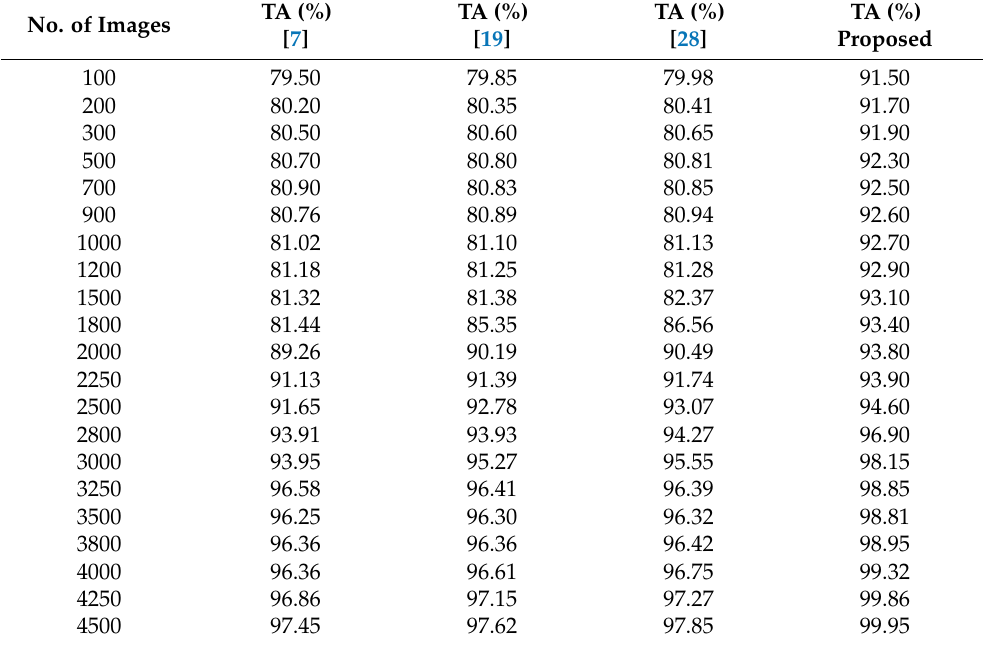
Table 1. Test accuracy for combined